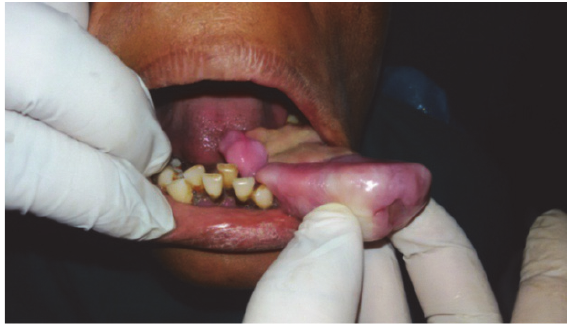
Figure 2: Intraoral preoperative lesion.